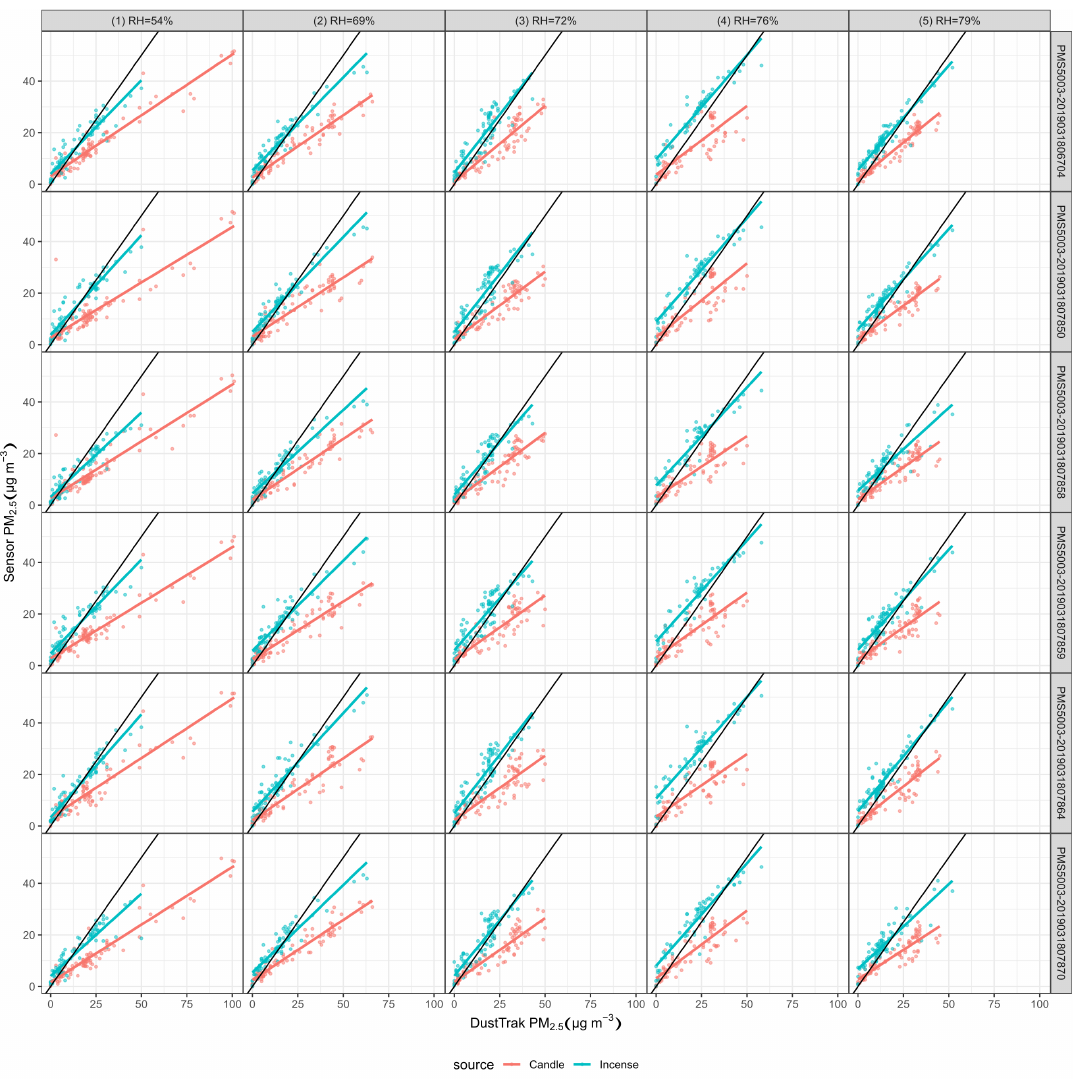
Figure A6. Comparison and linear regression of the Plantower PMS5003 with the DustTrak (x = DustTrak, y = sensors) during the five experiments for peaks and stable concentrations of PM generated using incense and candle. The black line is x =